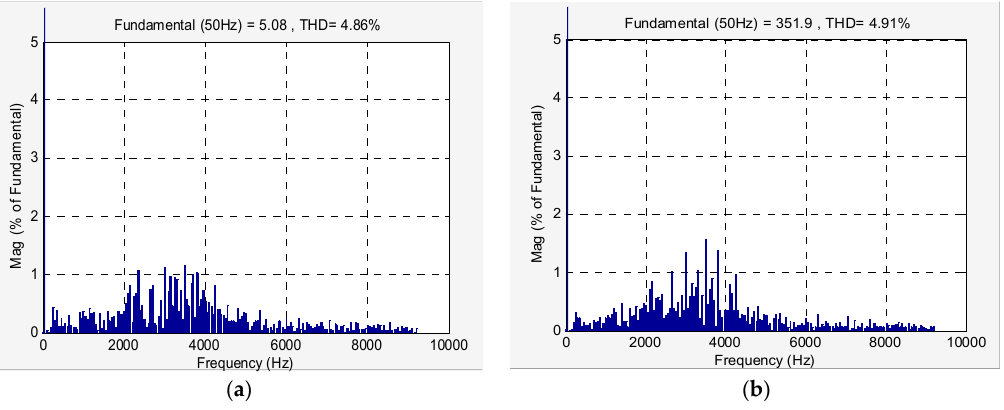
Figure 11. Harmonic content of the line currents ( a ) and of the load voltages ( b ).